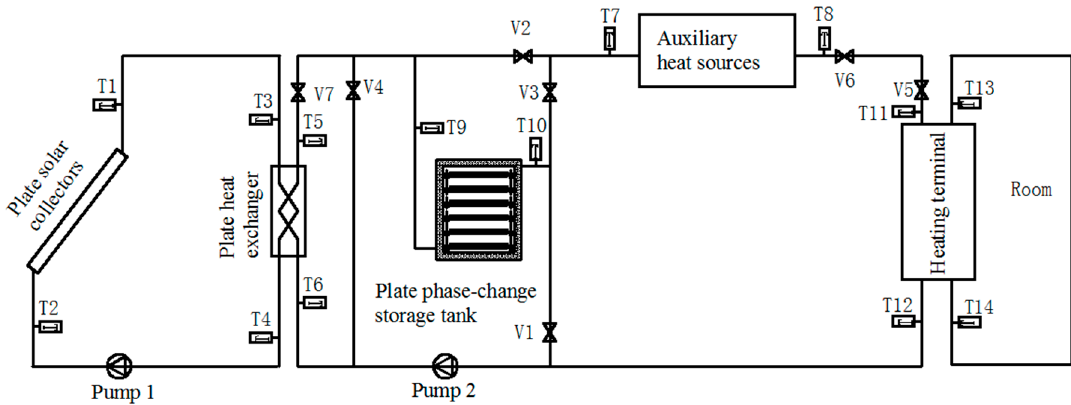
Figure 1. Schematic of the investigated SHS-PCM.